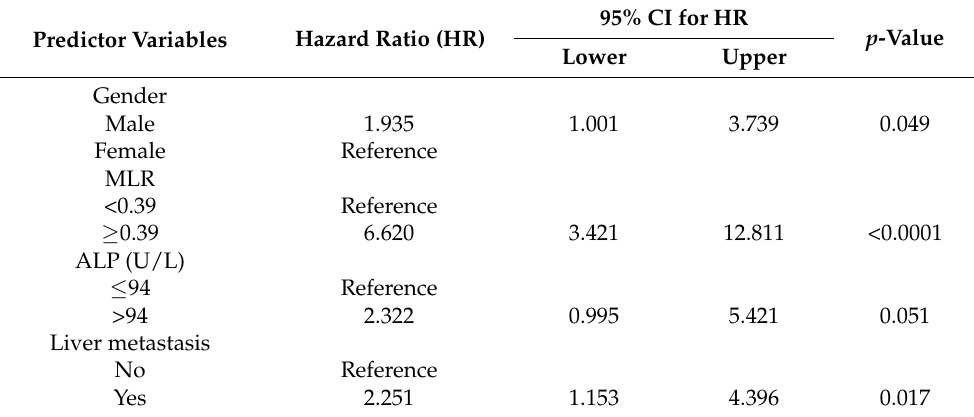
Table 3. Multivariable model of predictors for 6-month mortality risk among patients treated with G-based